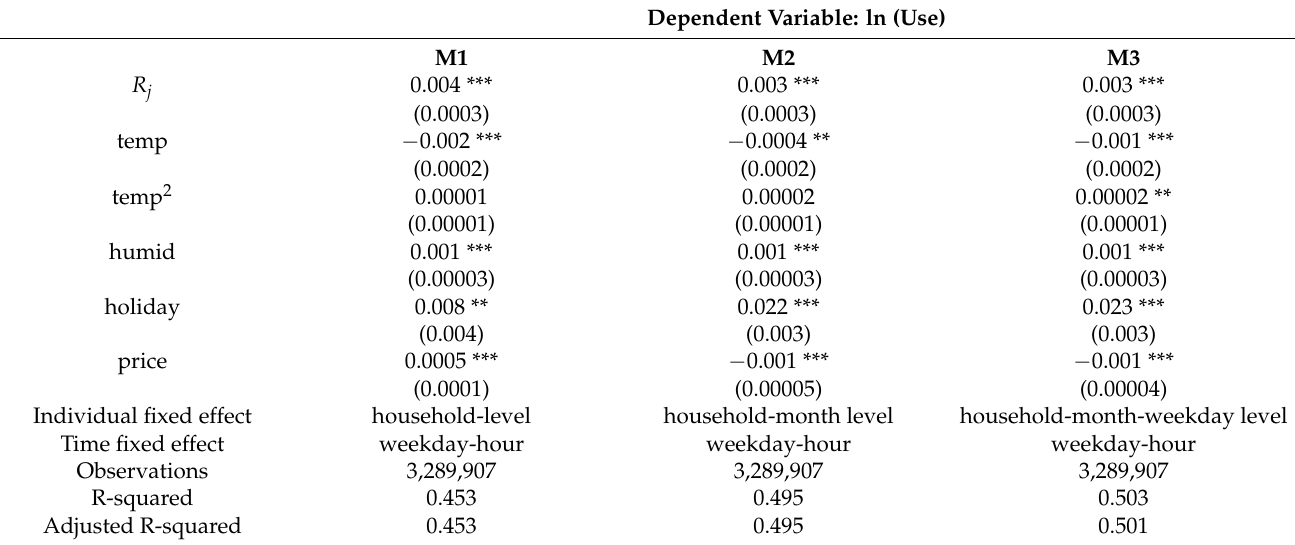
Table 4. Models to estimate the impact of COVID-19 on household energy